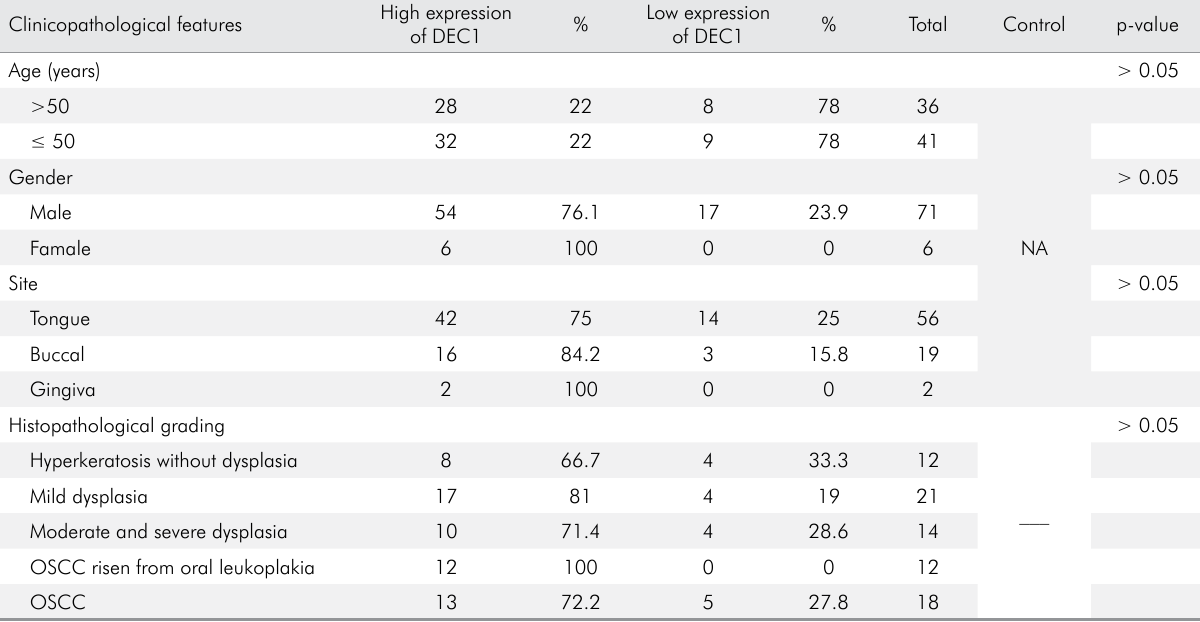
Table 3. Analysis of association between clinicopathological information and DEC1 expression.